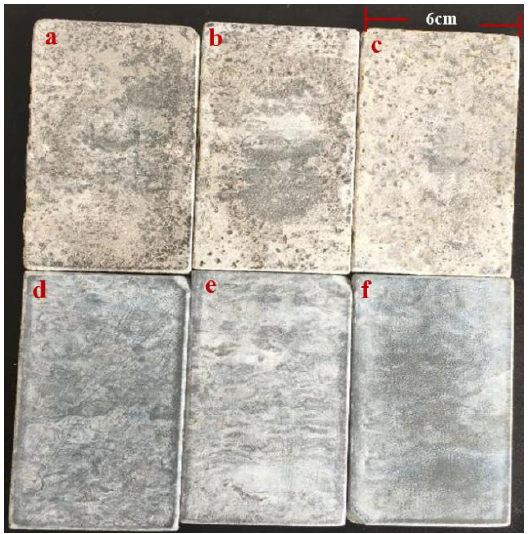
Figure 3. Appearance of the coating after removal of corrosion products after salt spray (3500/5000/7500 h from left to right, respectively): ( a – c ) the thermal-spray zinc coating; ( d – f ) inor- ganic zinc-rich coating.